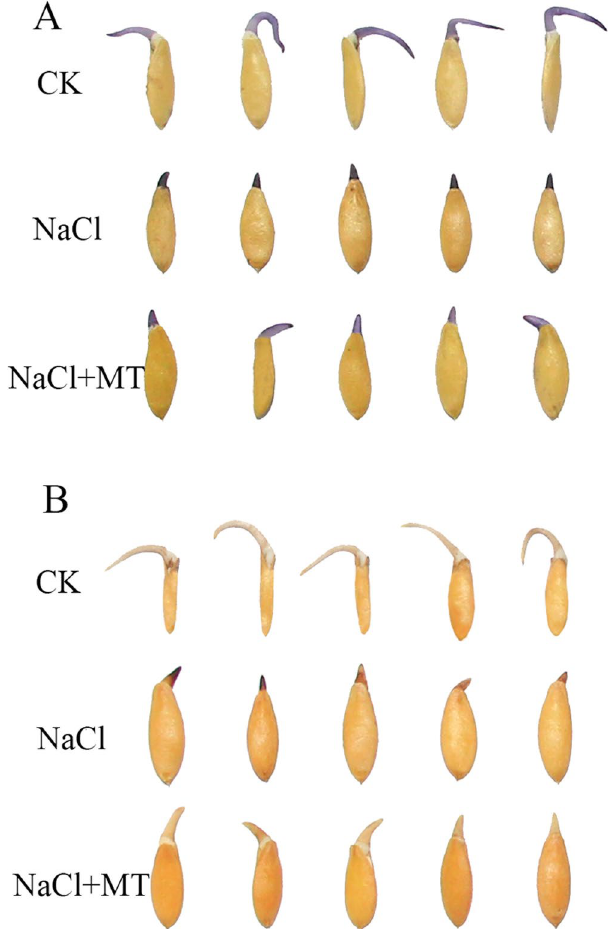
Figure 3. Detection of superoxide anion ( A ) and Hydrogen peroxide ( B ) accumulation in cucumber seeds. NBT reacts with O 2 ˙ − to form a dark blue insoluble formazan compound. DAB is oxidized by H 2 O 2 in the presence of peroxidases and produces reddish brown